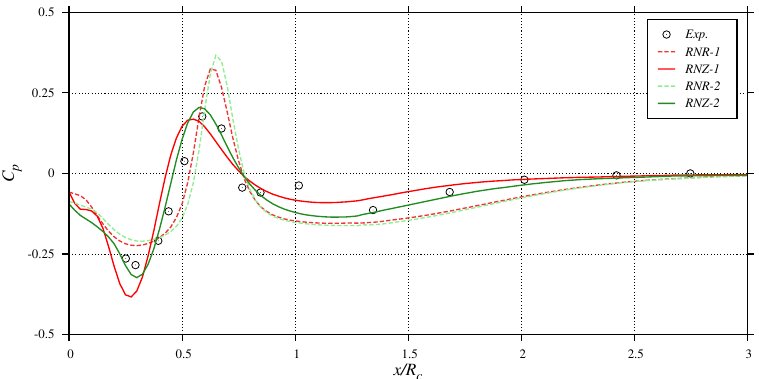
Figure 6. In-cylinder pressure coefficient development along the axial